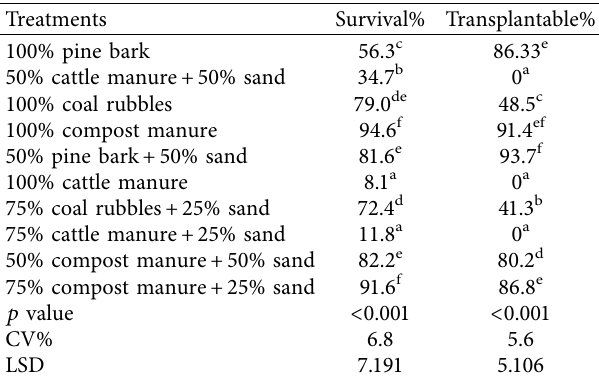
Table 2: The effect of soilless growing media on survival and transplantable (%) of tobacco seedlings.